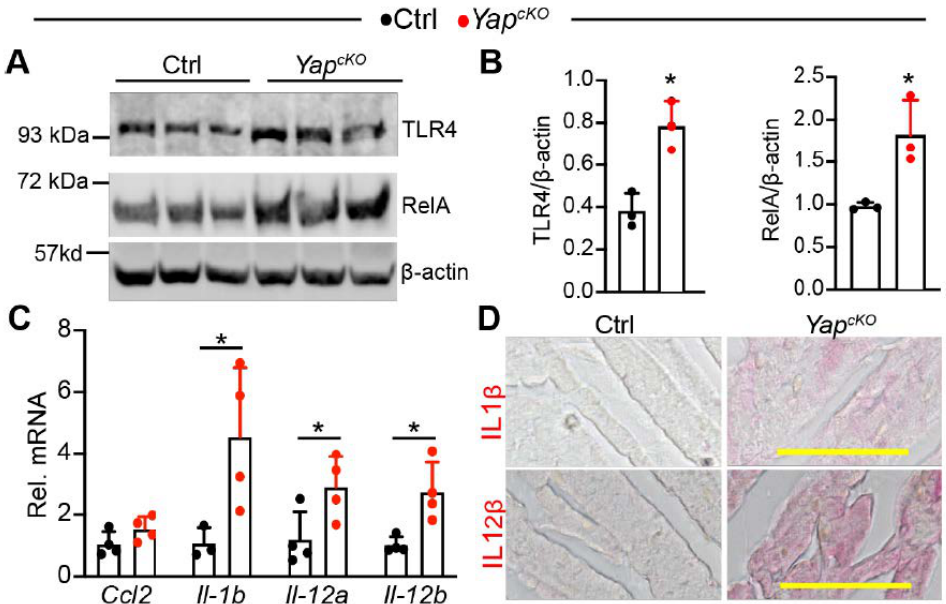
Figure 6. Cardiomyocyte-specific YAP depletion activates TLR4/NF- κ B pathway. ( A ). Immunoblot of TLR4 and RelA. Total heart protein from postnatal day 12 (P12) mice was used for immunoblot. ( B ). Densitometry quantification of TLR4 and RelA. The protein levels of TLR4 and RelA were normalized to β -actin. n = 3 for each group. ( C ). qRT-PCR measurement of pro-inflammatory genes. Total RNA from P12 heart was used. Gene expression level was normalized to Gapdh . n = 4. ( B , C ), student t -test, *, p < 0.05. ( D ). Immunohistochemistry staining of P12 myocardium. Alkaline phosphatase-based detection system was used to visualize the expression of IL-1 β and IL-12 β . Scale bar = 50 µ